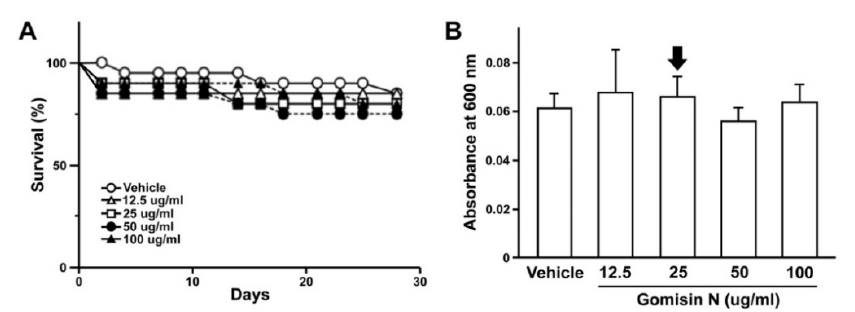
Figure 2. The effect of gomisin N on the survival of adult flies. ( A ) The viability of adult flies treated with gomisin N was measured by the survival rate. Flies were treated with various concentrations of gomisin N for up to 4 weeks ( n = 12 per group). ( B ) The consumption of gomisin N was measured by monitoring the absorbance at 600 nm (OD 600 ). Mean ± SEM are indicated for experiments repeated three times. The concentration selected for subsequent experiments is indicated with a black arrow.